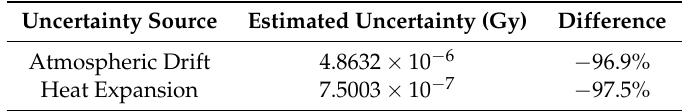
Figure 13. Dose-defect maps generated using the virtual dosimeter with equalised path lengths. ( a ) Dose defect map generated by simulating atmospheric drift. ( b ) Dose defect map generated by simulating heat expansion. Note the different scales. Table 7. Dose-defect uncertainties generated on the equalised dosimeter by atmospheric drift and heat expansion tabulated against the percentage difference from the original configuration.